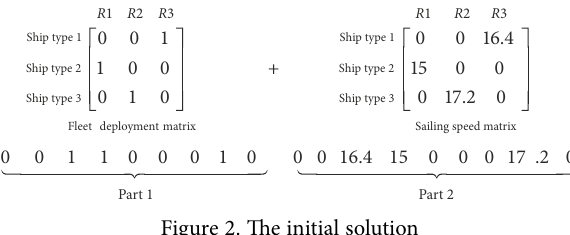
Figure 2. The initial